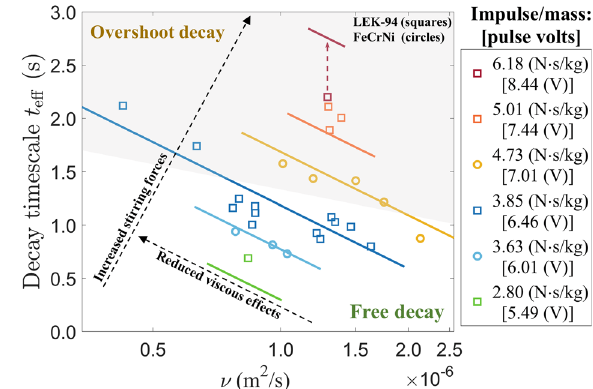
Fig. 5 The decay timescale of effective viscosity t eff for different experimental cases as a function of kinematic viscosity ν (log- scale) and impulse amplitude I . The solid lines represent the empirical relation obtained from the data fi t.